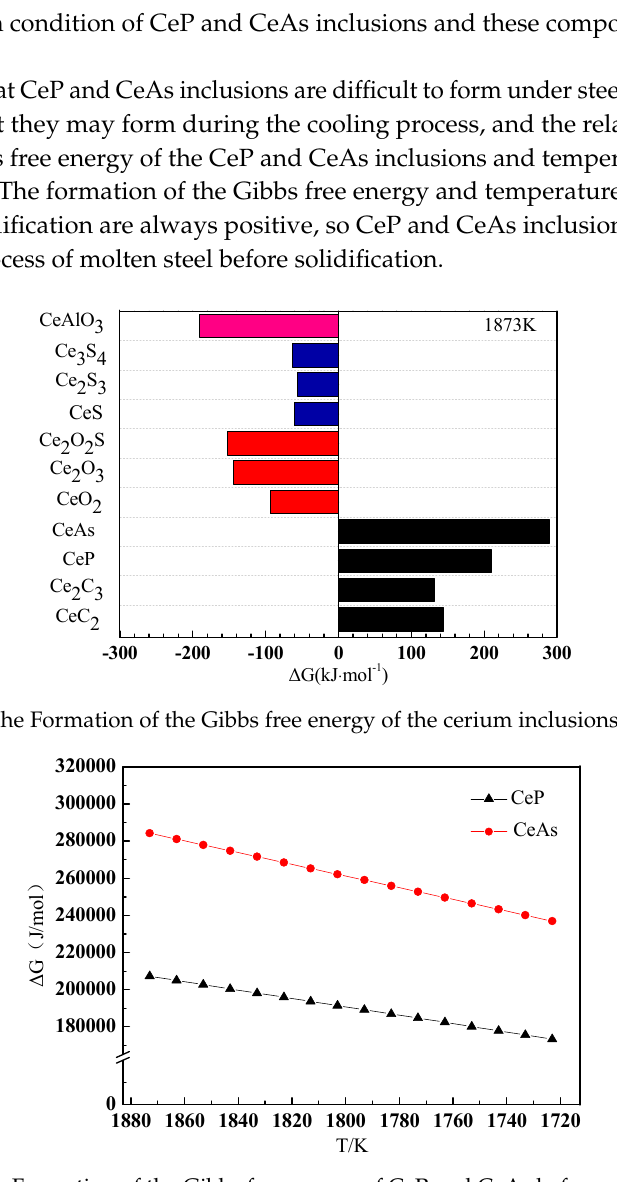
Figure 9. The Formation of the Gibbs free energy of CeP and CeAs before solidification.